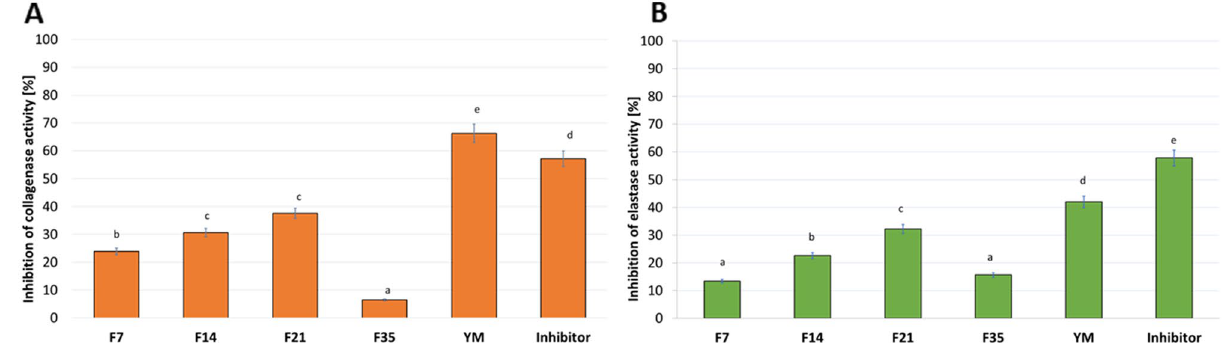
Figure 8. Influence of Yerba Mate extract and Kombucha ferments on collagenase ( A ) and elastase ( B ) inhibition. Data are the mean ± SD of three independent experiments, each of which consists of three replicates per treatment group. Different letters on the charts indicate significant differences between groups ( p <